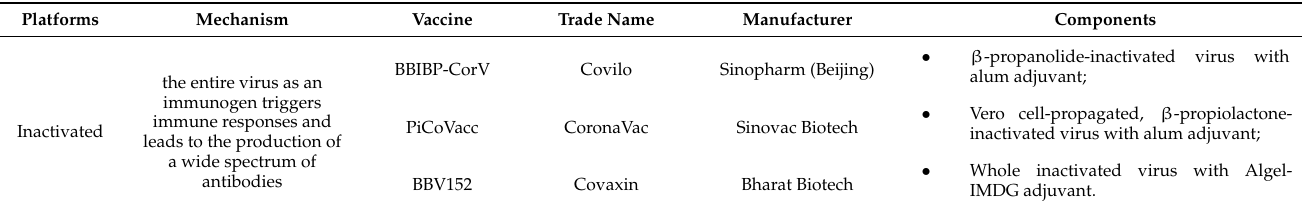
Table 1. The features of COVID-19 vaccines commonly